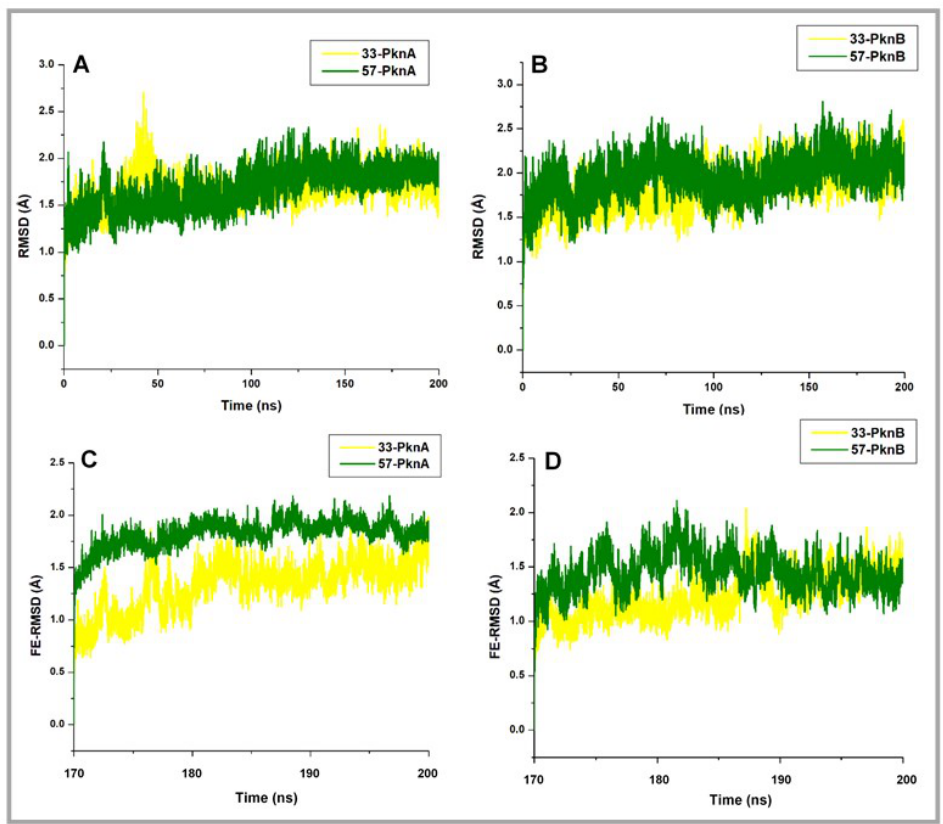
Figure 2. RMSD plots showing variations across the entire PknA and PknB structures as induced by the binding of 33 and 57 . Finally equilibrated RMSD (FE-RMSD) plots estimating minimal Cα deviations for the ultimate 30 ns time frames are also shown. ( A ) Whole structure RMSD plot for 33 - and 57 -bound PknA ( B ) Whole structure RMSD plot for 33 - and 57 -bound PknB ( C ) FE-RMSD plots for 33 - and 57 -bound PknA ( D ) FE-RMSD plots for 33 - and 57 -bound PknB.